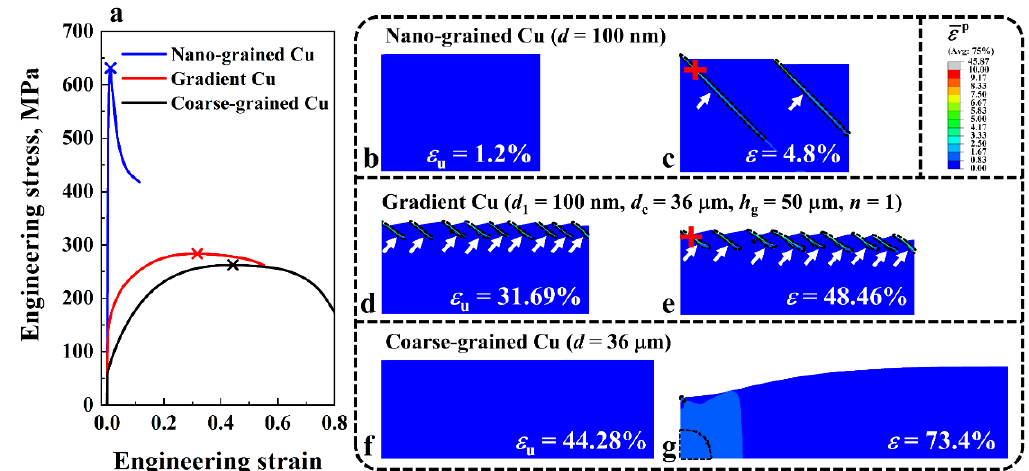
Figure 5. ( a ) Engineering stress-strain curves of the NG, gradient, and CG Cu. ( b – g ) Deformation behavior of the NG, gradient, and CG Cu during tension. Regions where the equivalent plastic strain ε p is larger than 1 are enclosed by black dashed lines.